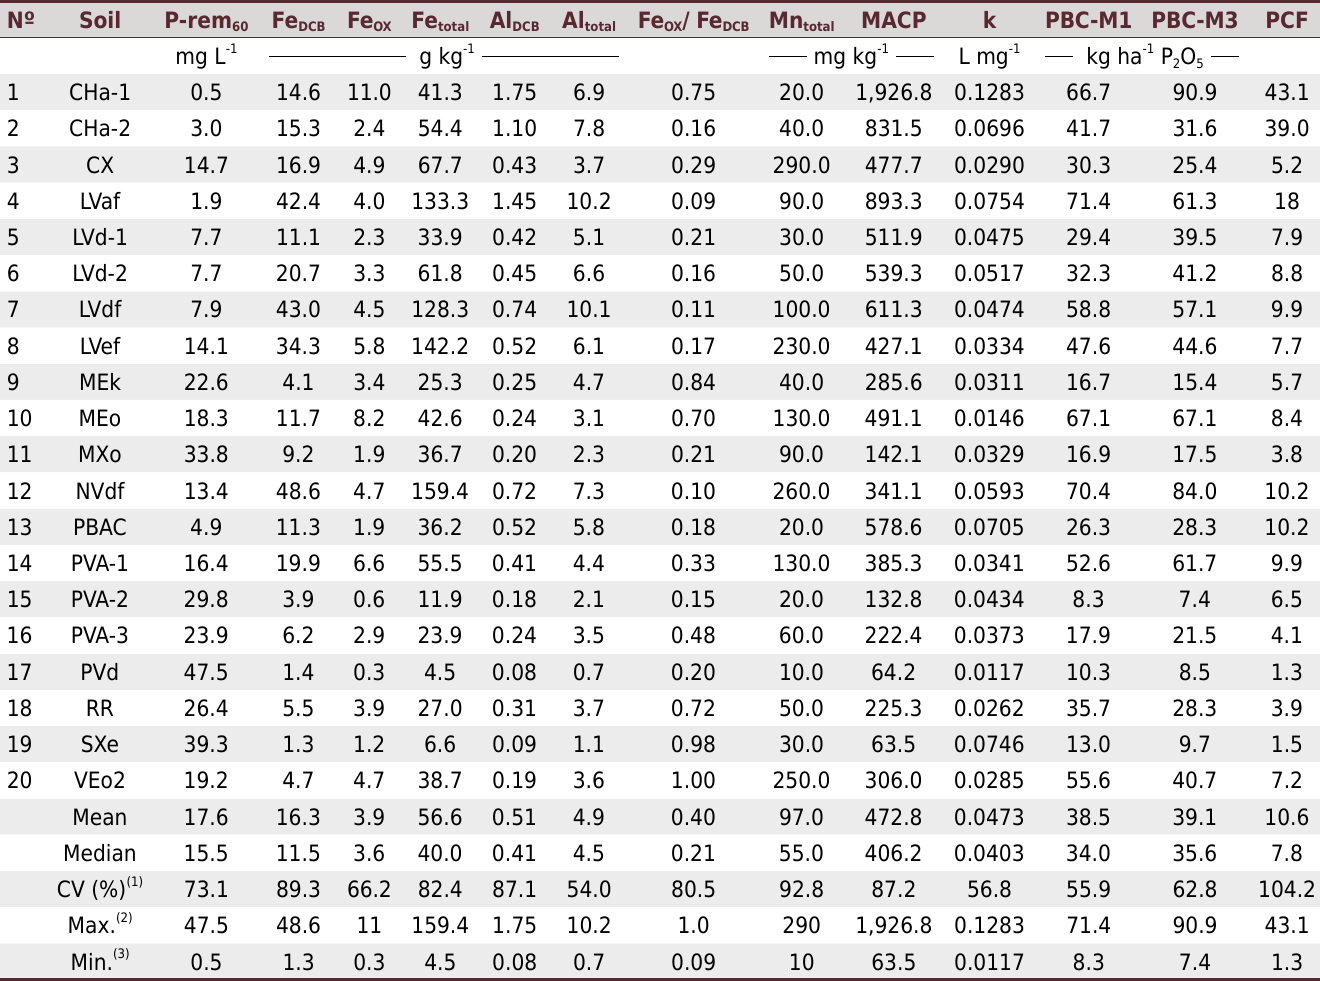
Table 2. Chemical attributes and measurements related to the P buffering capacity of the soils studies Nº Soil